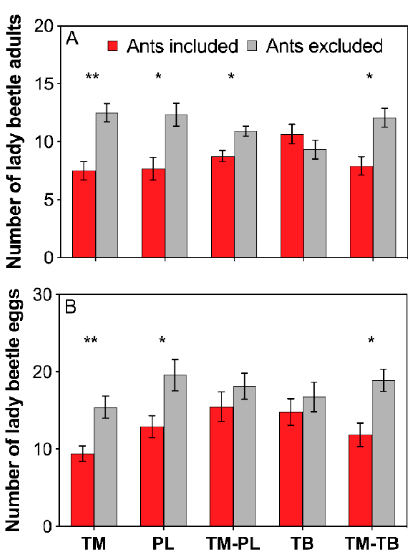
Figure 3. Effects of interference competition on predator performance. ( A ) number of lady beetle adults; ( B ) number of lady beetle eggs. The data are presented as the mean ± SE. Asterisk (* or **) on bars indicates significant differences between ant treatments ( P < 0.05 or P < 0.01). Tapinoma melanocephalum , Paratrechina longicornis , Tetramorium bicarinatum , Tapinoma melanocephalum - Paratrechina longicornis confrontation and Tapinoma melanocephalum - Tetramorium bicarinatum confrontation were abbreviated into TM, PL, TB, TM-PL and TM-TB, respectively.